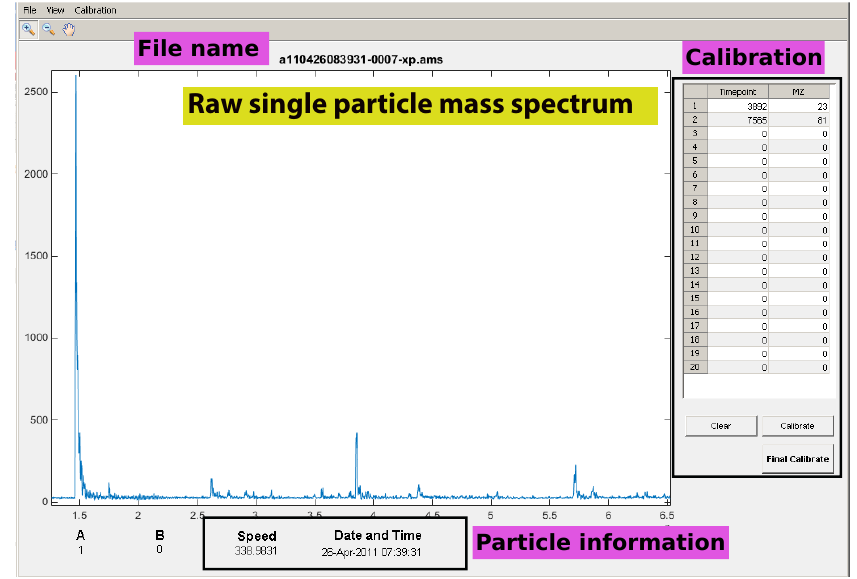
Figure 4. Screenshot of a calibFATES window displaying a single-particle uncalibrated mass spectrum. Calibration data are input and displayed on the right, and particle size and time are displayed on the